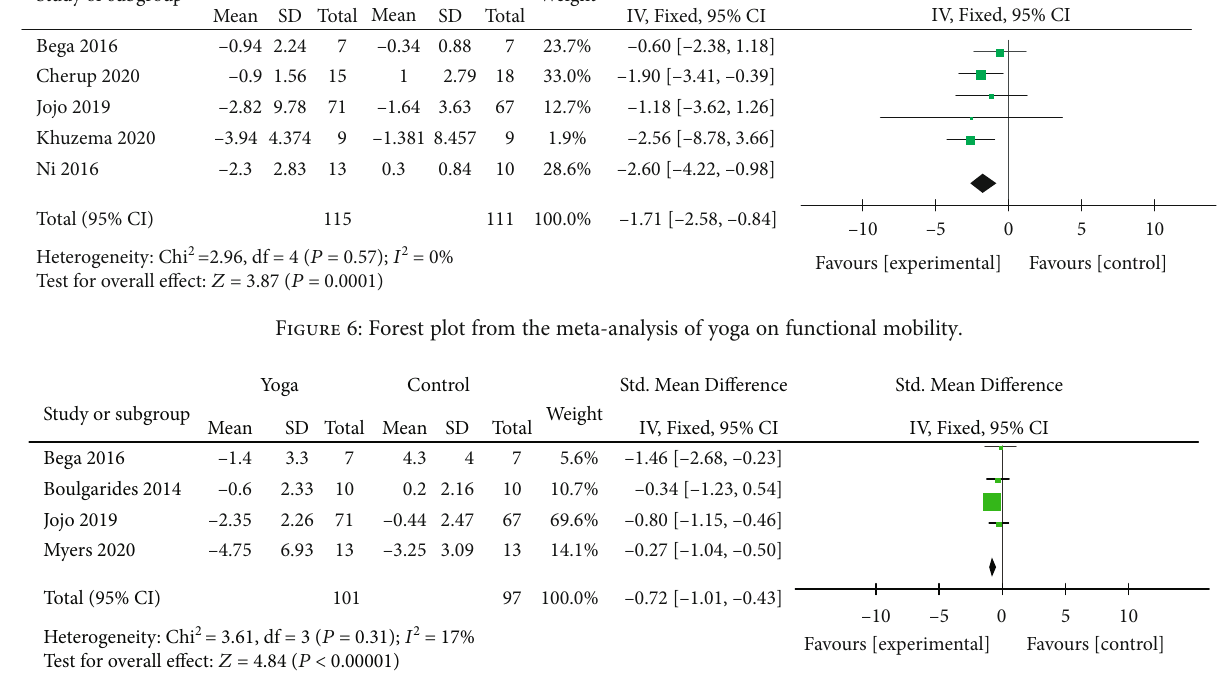
Figure 7: Forest plot from the meta-analysis of yoga on